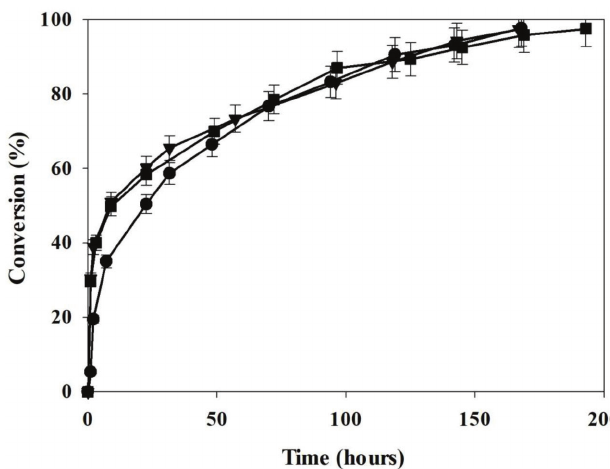
Fig. 5 – Conversion variation with time for PGPR synthesis in the vacuum reactor after first, second, and third use. Reac - tion conditions: 30 g ricinoleic acid, 2.5 g polyglycerol-3, 3.6 g immobilized derivative, 70 °C, 350 rpm. (●) first, (▼) second, and (■) third